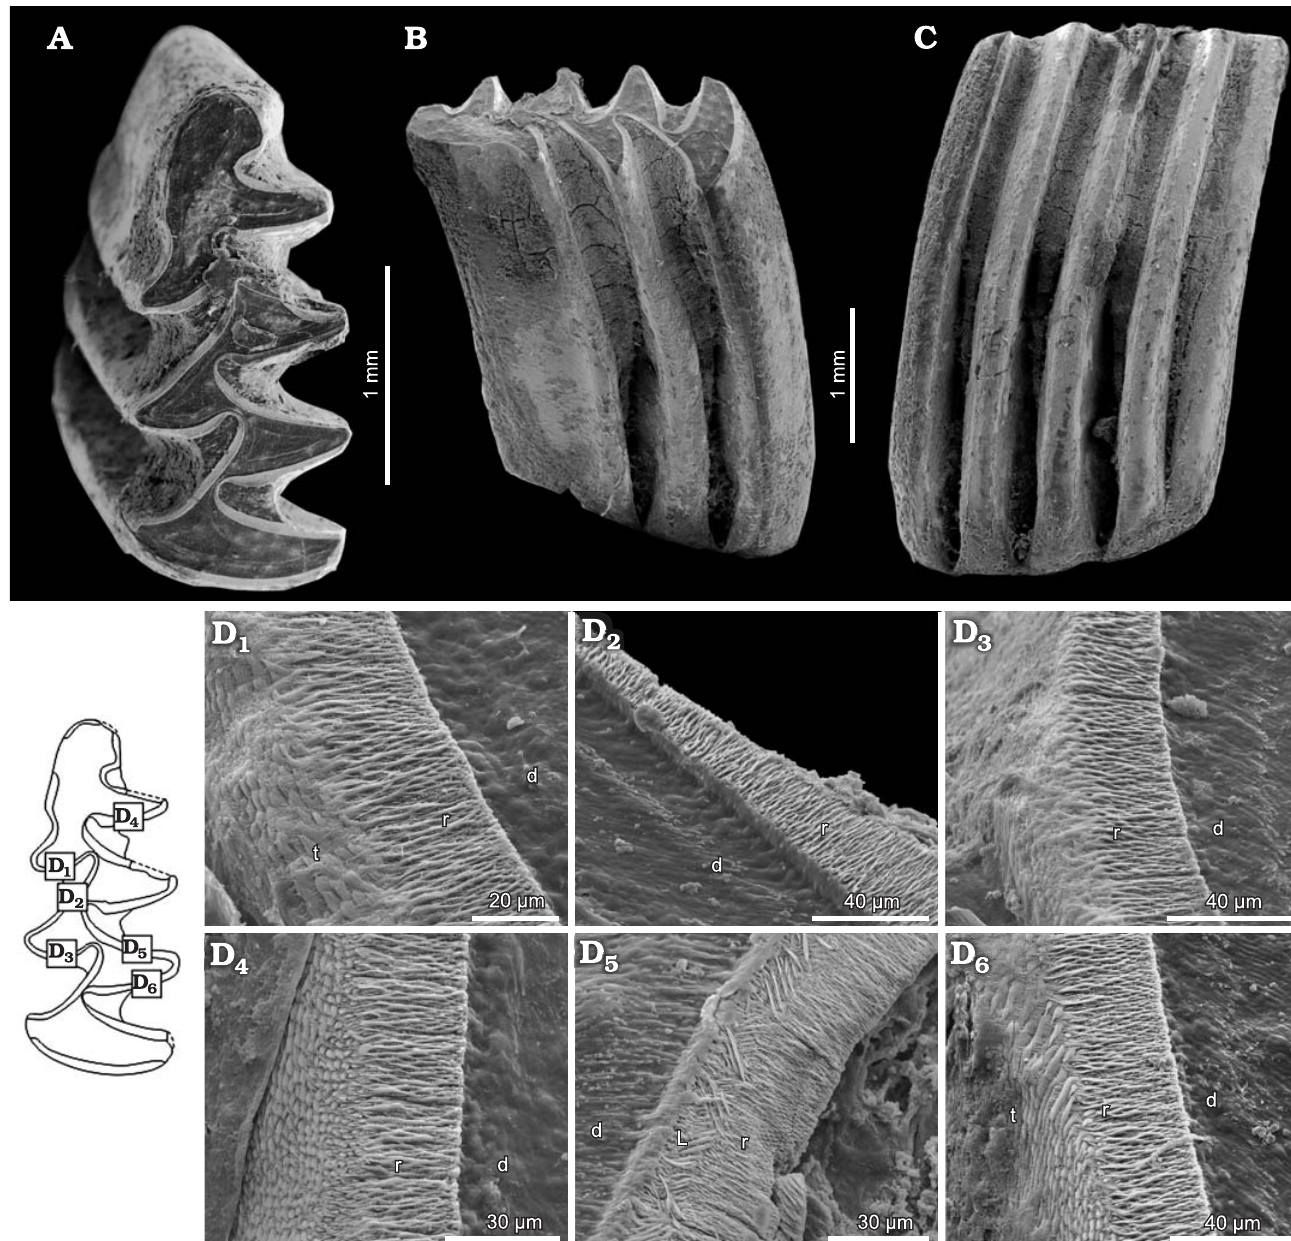
Fig. 4. Vole Mimomys chandolensis sp. nov. (ZIN 101600) from Primorsky Krai, Russia, Late Pleistocene (MIS 3). Left m1 in occlusal ( A ), buccal ( B ), and lingual ( C) views, and photographs of the enamel ultrastructures ( D ). Positions of D 1 –D 6 indicated on the drawing. Abbreviations: d, dentine; L, lammelar enamel layer; r, radial enamel; t, tangential